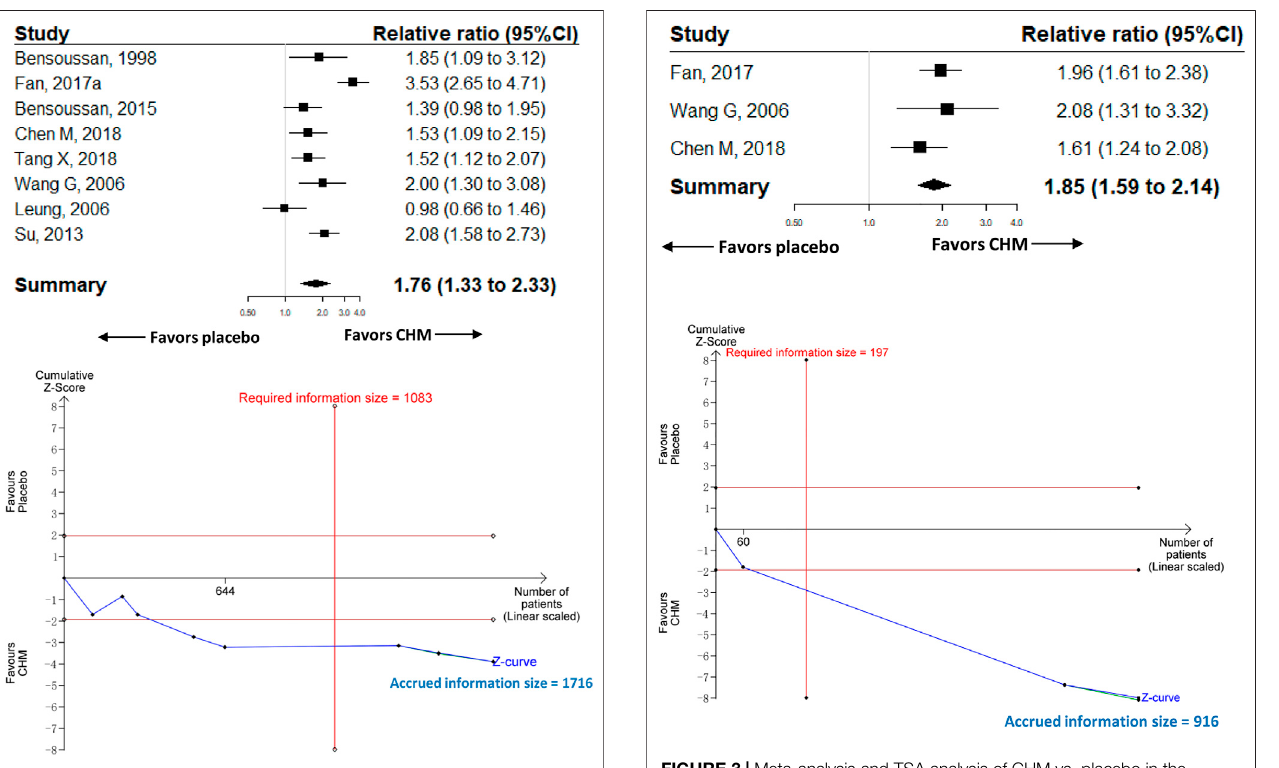
FIGURE 2 | Meta-analysis and TSA analysis of CHM vs. placebo in the adequaterelief ofglobal IBSsymptoms.CHM,Chineseherbalmedicine.TSA, trial sequential analysis. The results of meta-analysis were shown on the top half, and the results of TSA were showed on the bottom half. The red verticallinerepresentedtherequiredinformationsize(RIS)forthecomparison, assuming adifference of20%intheproportion ofadequaterelief ofglobal IBS symptoms. The blue line represented the cumulative Z curve, and the black dots represented the included studies added according to their publication year in ascending order.